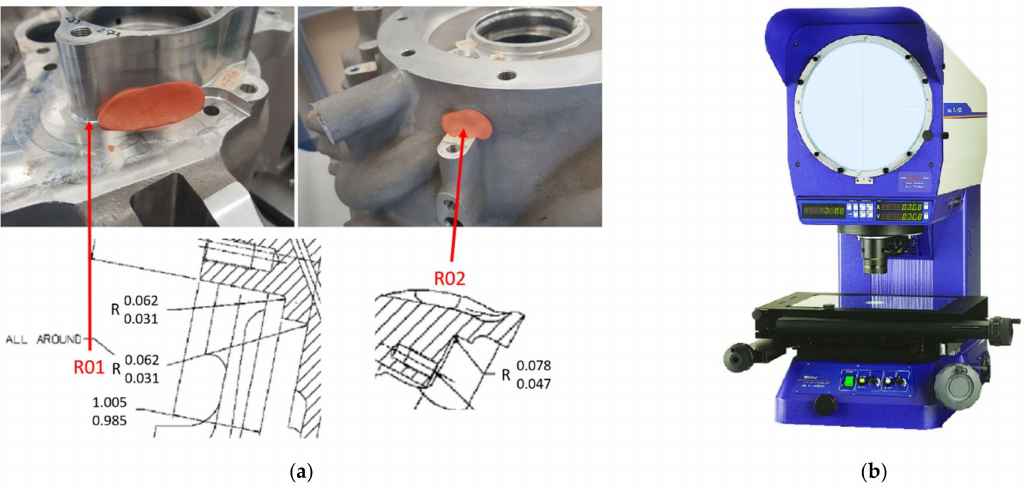
Figure 3. Measuring geometry using imprints, ( a ) taking imprints, ( b ) measurement projector.